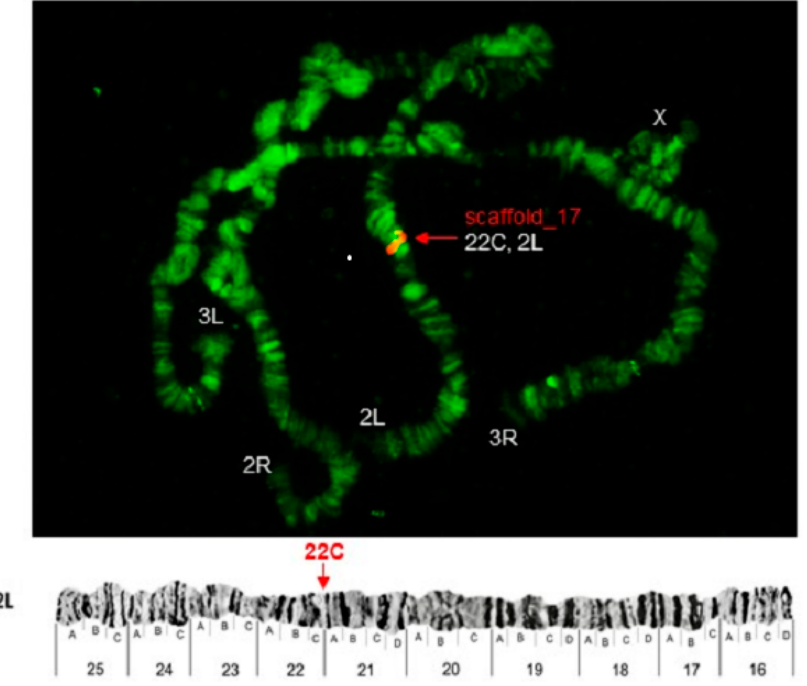
Figure 7. Pb23r-Cy 3 probe mapped in 2L (22C). Chromosomal bands with positive hybridization are identified with text in red, and the corresponding scaffolds in An. darlingi genome assembly AdarC3 are indicated in white text.